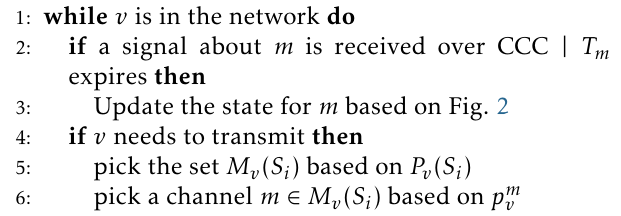
Figure 3. Directional antenna creates more channel availabili- ties.